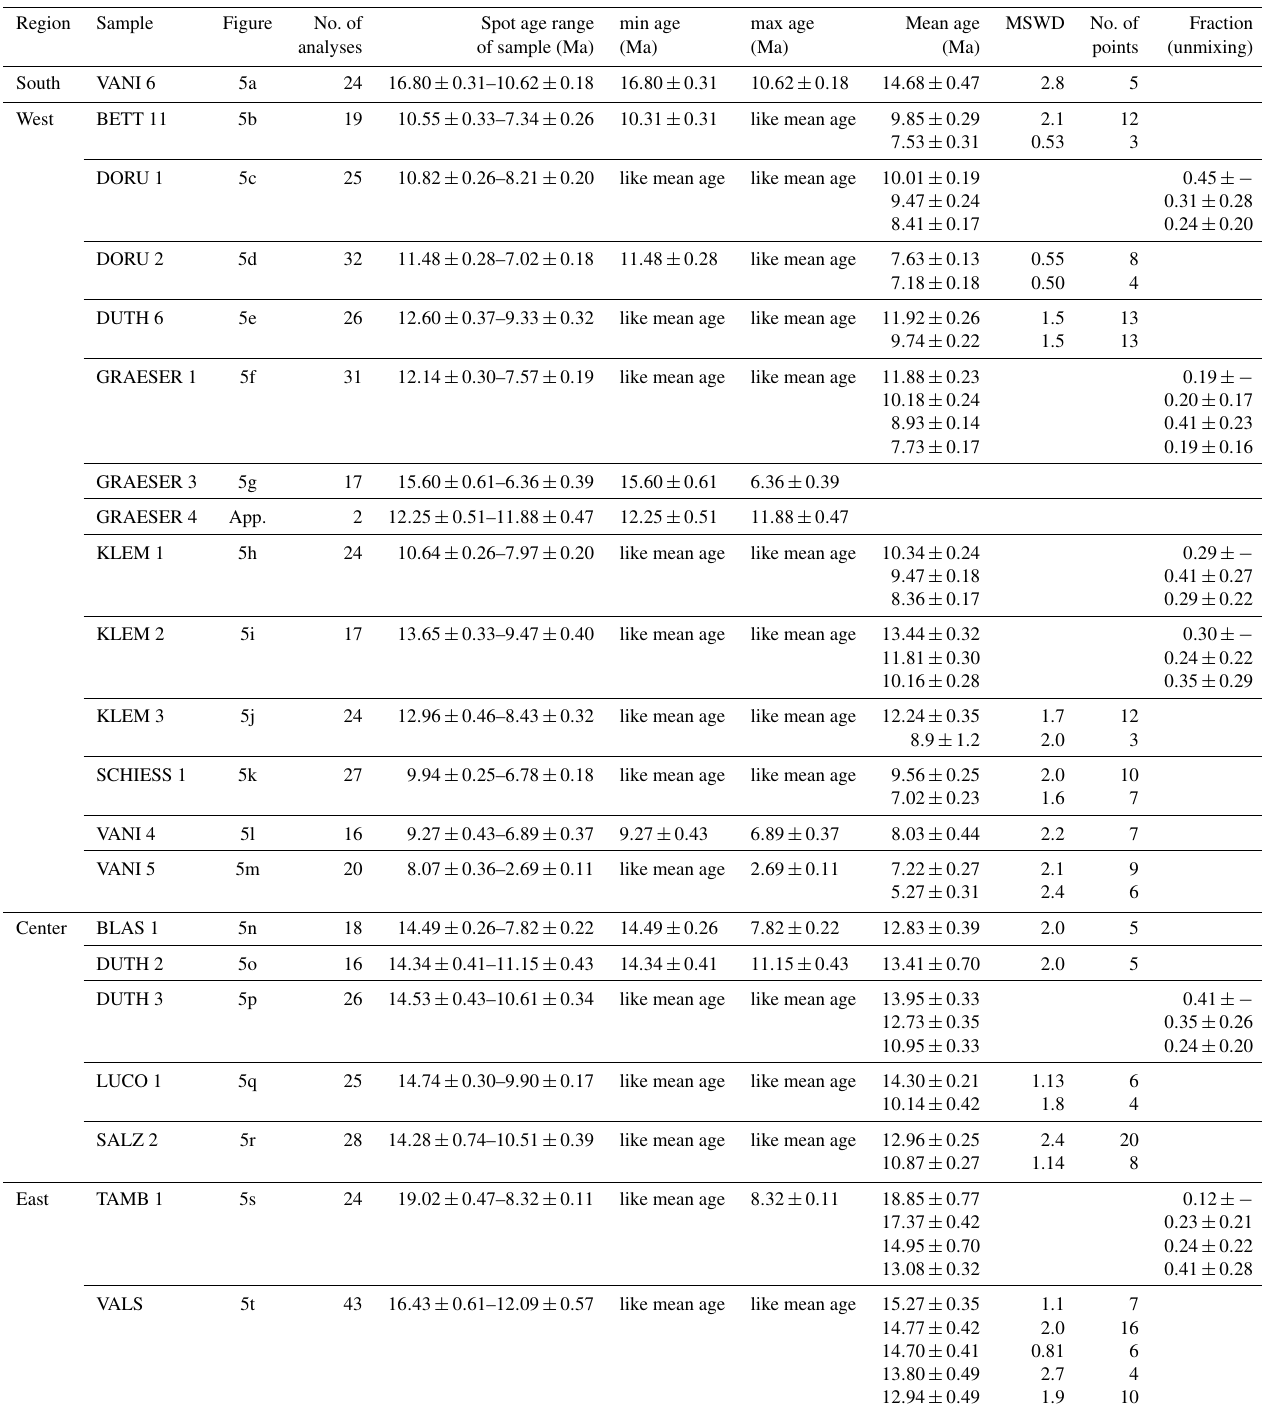
Table 2. Overview list of the 232 Th– 208 Pb age range and significant minimum and maximum ages obtained for each grain and weighted mean domain ages that could be calculated for the